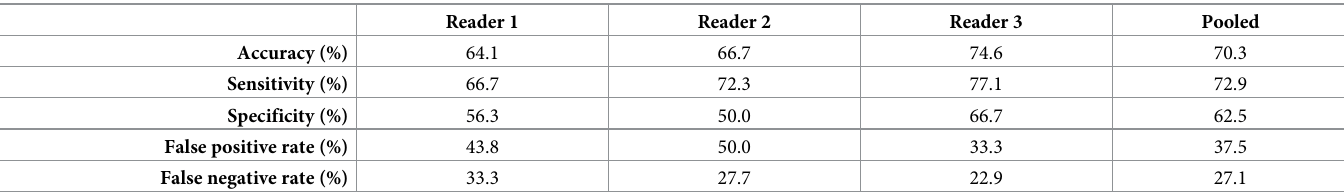
Table 3. Diagnostic performance for PICT detection of the three readers.